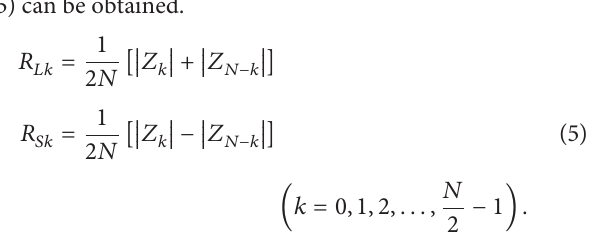
Figure 2: Ellipse